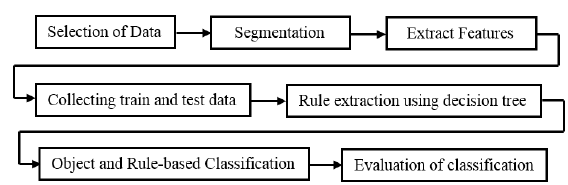
Figure 2. Flowchart of the proposed methodology